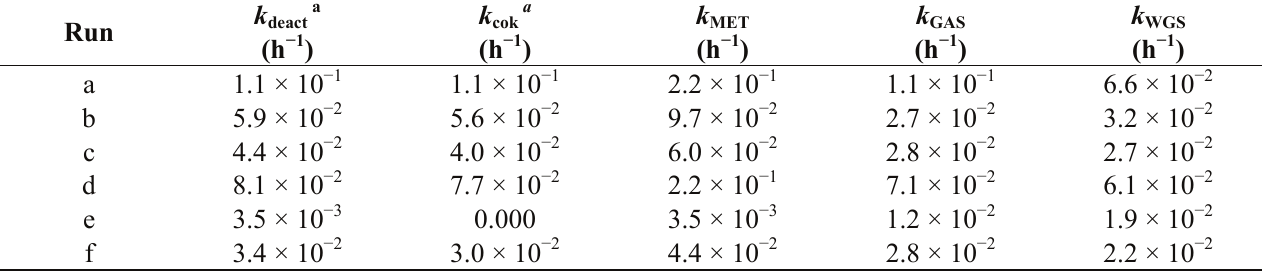
Table 4. Deactivation constants of the various functionalities ( T , 450 °C): hexane conversion ( k ), methanation ( k ), gasification ( k ), water-gas-shift ( k deact MET GAS